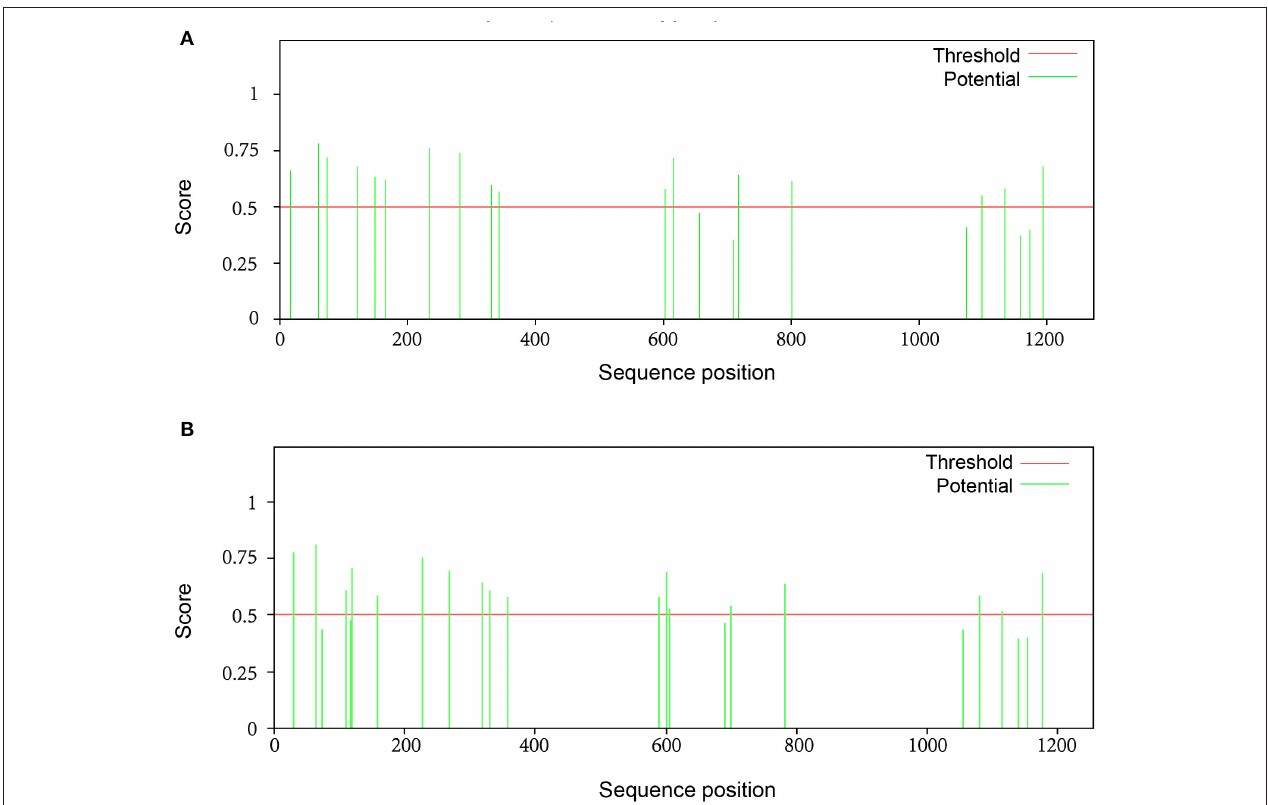
FIGURE 6 | The potential N-glycosylation sites on the spike protein of SARS-CoV-2 and SARS-CoV. To identify significant differences in glycosylation patterns between SARS-CoV-2 and SARS-CoV, the potential N-glycosylation sites (green line) were predicted using the relevant web server: http://www.cbs.dtu.dk/services/ NetNGlyc. There were (A) 22 potential N-linked glycosylation sites and (B) 24 potential N-linked glycosylation sites on S protein of SARS-CoV-2 and SARS-CoV, respectively. The default threshold was set at 0.5 (red